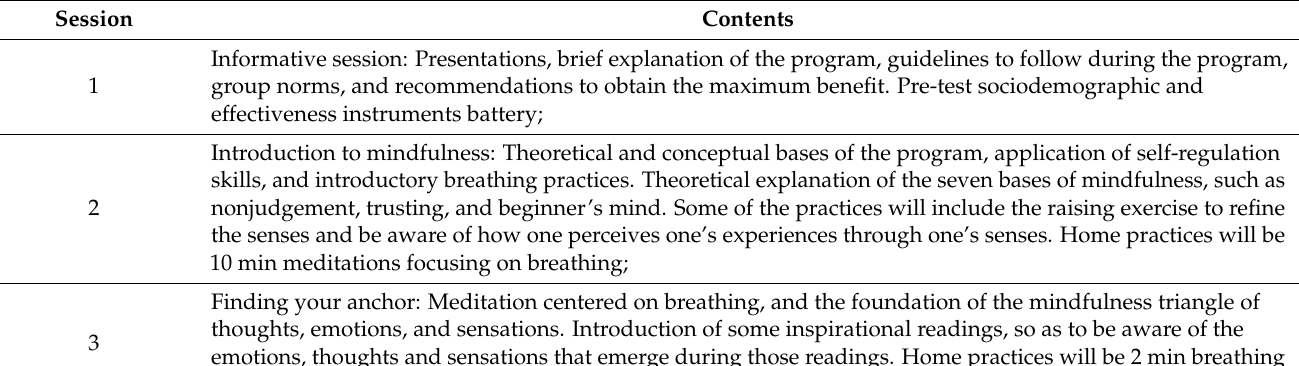
Table 1. Sessions and contents of the